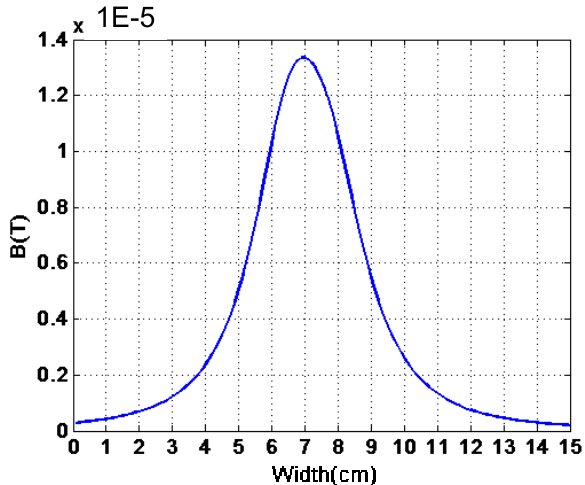
Figure 8. Shielding influence